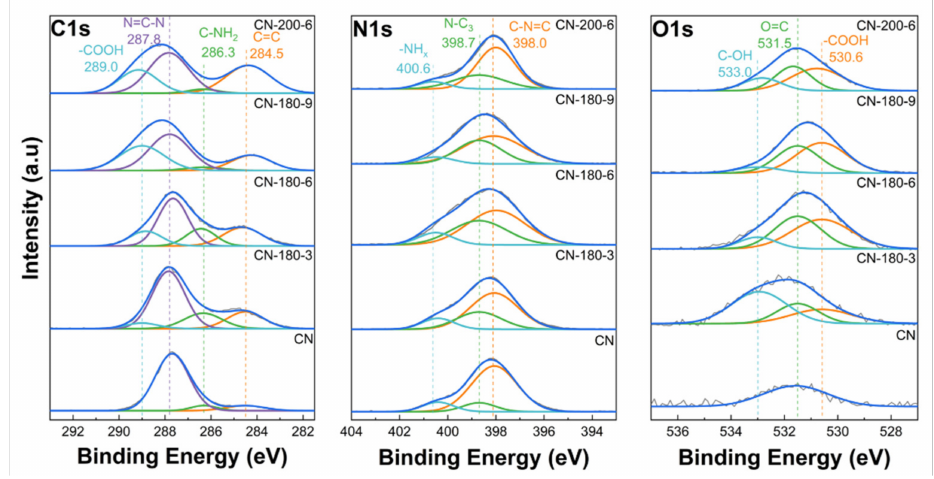
Figure 4. XPS data of C 1s, N 1s, and O 1s for all the photocatalysts. Table 2. C/N and O/N atomic ratios of all prepared samples were obtained from elemental analysis. Element Analysis Samples Atom (wt%) Atomic